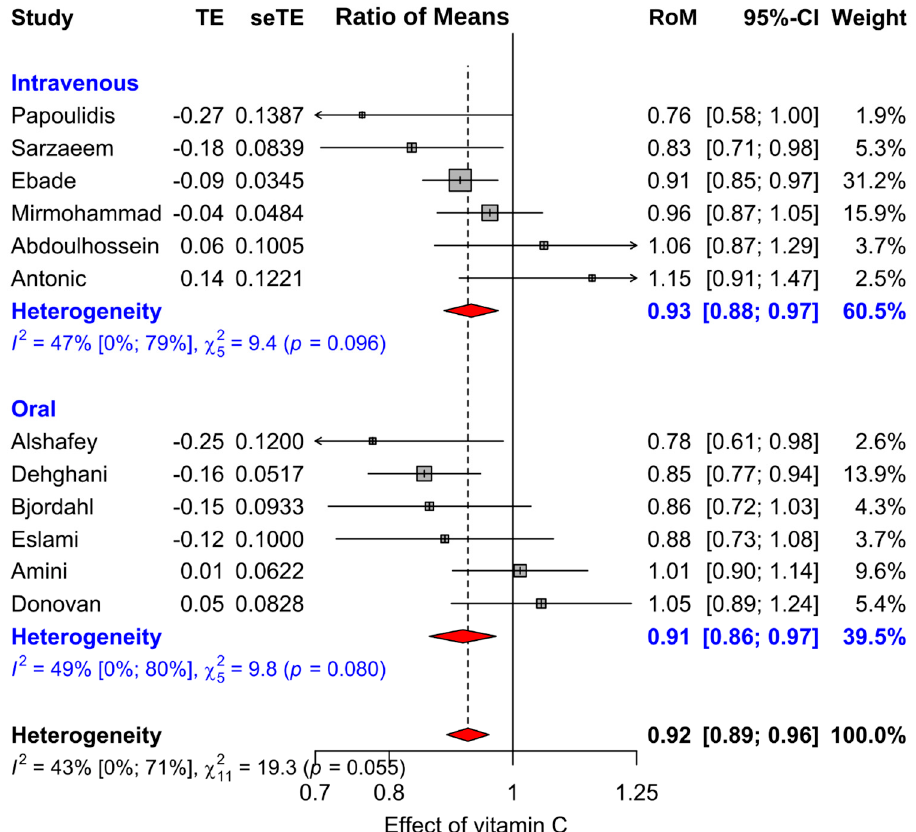
Figure 3. The effect of vitamin C supplementation on the length of ICU stay. This meta-analysis is termed final meta-analysis in Table 2. Subgroups of this set of 12 trials are shown in Table 2. The horizontal lines indicate the 95% CI for the vitamin C effect and the squares in the middle of the horizontal lines indicate the point estimates of the effect in the particular trial. The diamond shape indicates the pooled effect and its 95% CI. When the squares and diamonds are on the left-hand side of the vertical control level, they indicate that vitamin C is better than control. The reference numbers to the trials are shown in Table 1. Abbreviations: RoM, ratio of means; TE, logarithm of RoM, seTE; the standard error of TE; see ref. [127].